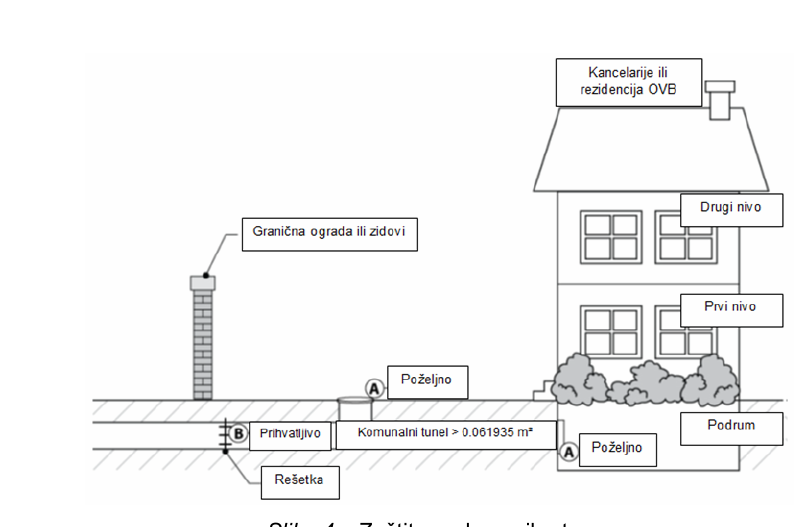
Figure 4 – Protection of subterranean